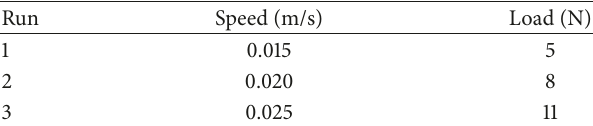
Table 2: Assignment of the levels to the